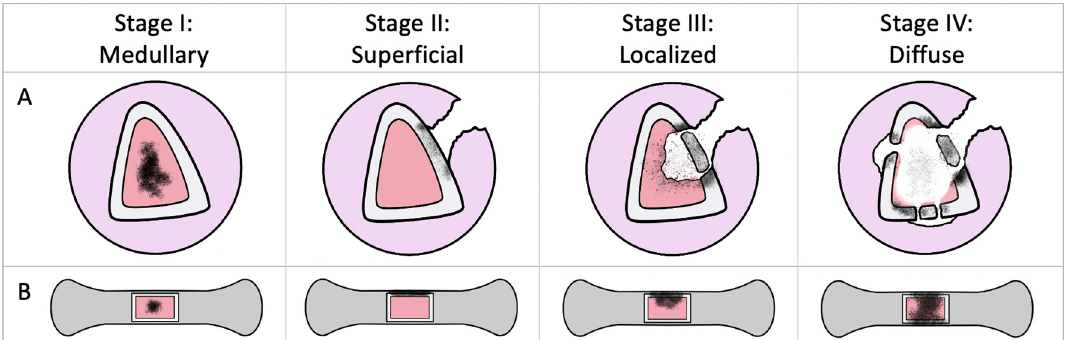
Figure 1. Simplified Cierny–Mader classification. Panel A: cross-sectional view of osteomyelitis in a long bone. Panel B: a longitudinal view with a window of bone removed. Stage 1 (medullary) osteomyelitis is confined to the medullary cavity. Stage 2 (superficial) involves the cortical bone and